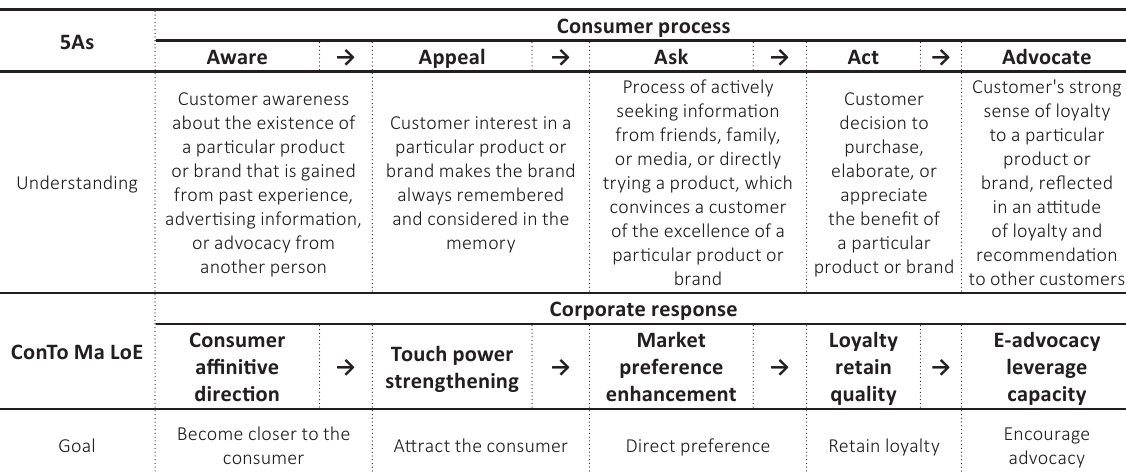
Table 1. Compatibility of 5As and